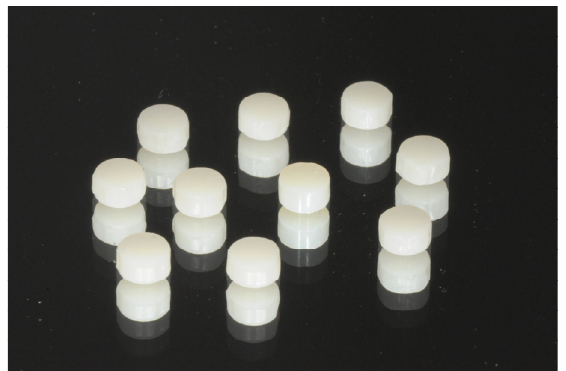
Figure 5. PMMA and G-PMMA cylindrical samples.